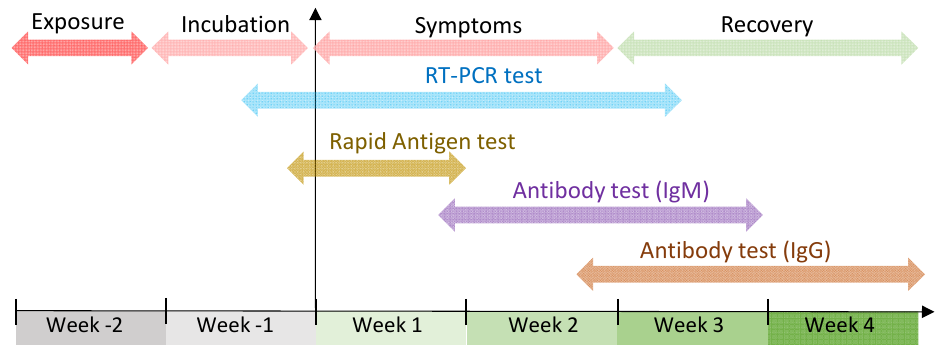
Figure 1. Suitability of different types of in vitro diagnostic tests during the progression of COVID-19 infection. Approximate time intervals of SARS-CoV-2 exposure, incubation, symptoms, and recovery are illustrated. The detectability of the viral genetic material, viral proteins, and antibodies (IgM and IgG) to the virus are shown for the RT-PCR test, rapid antigen test, and antibody tests, respectively.